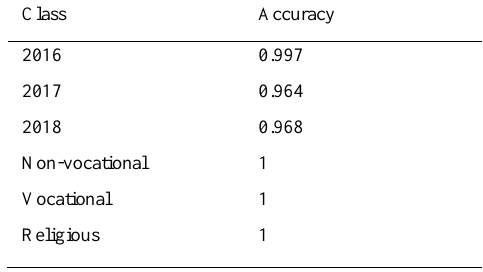
Table 4. Image model accuracy for each class on training dataset